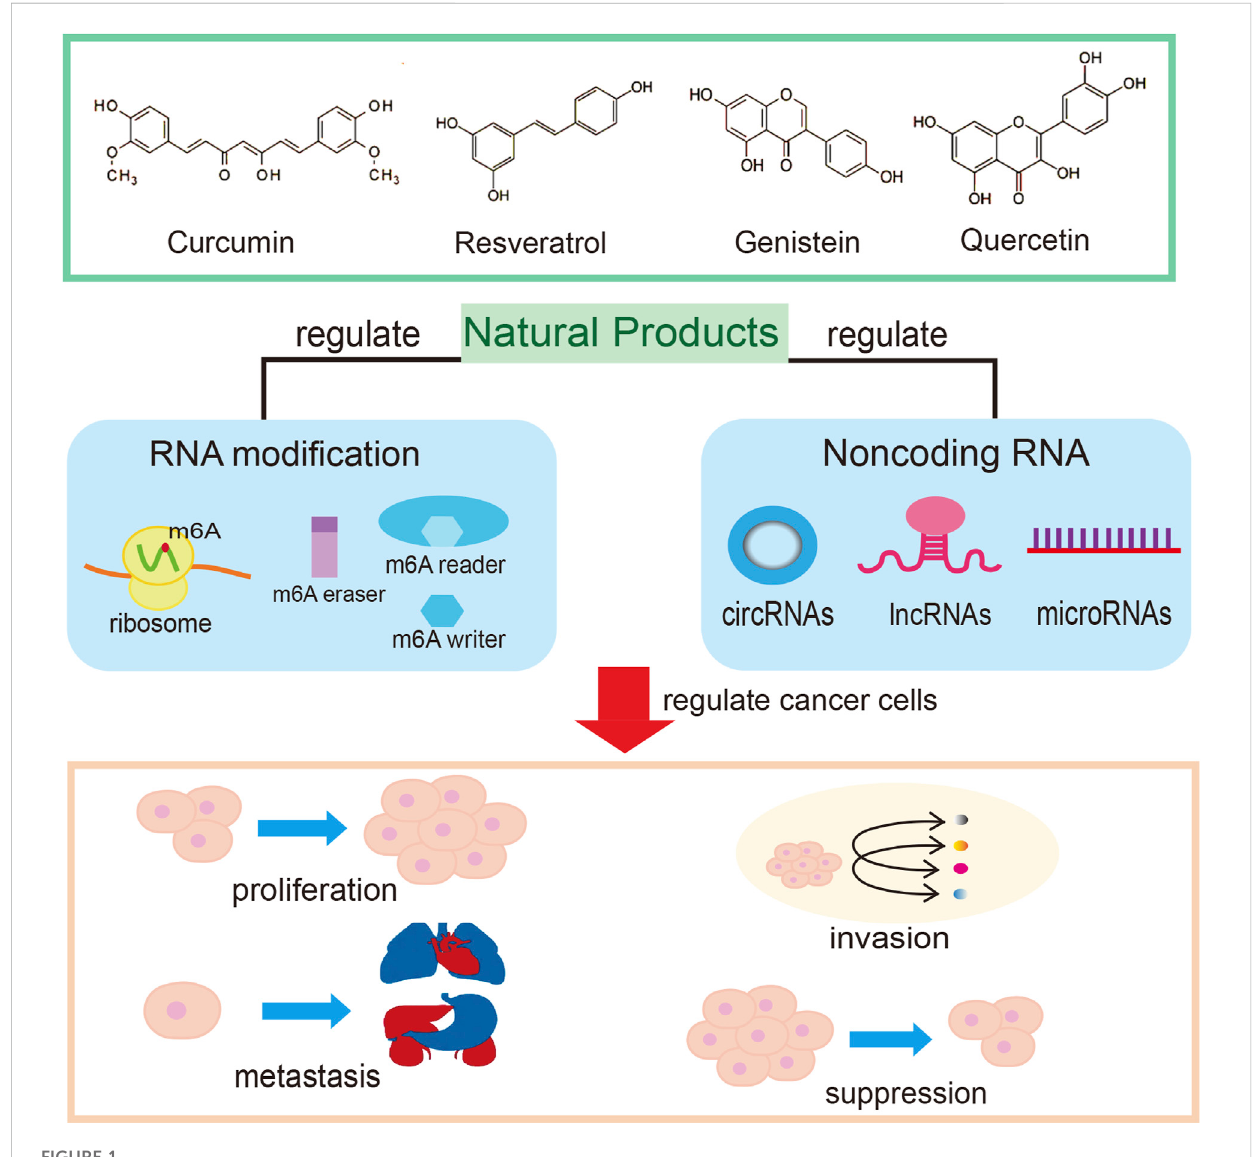
FIGURE 1 ncRNAs and RNA modi fi cations underlying natural products-based cancer